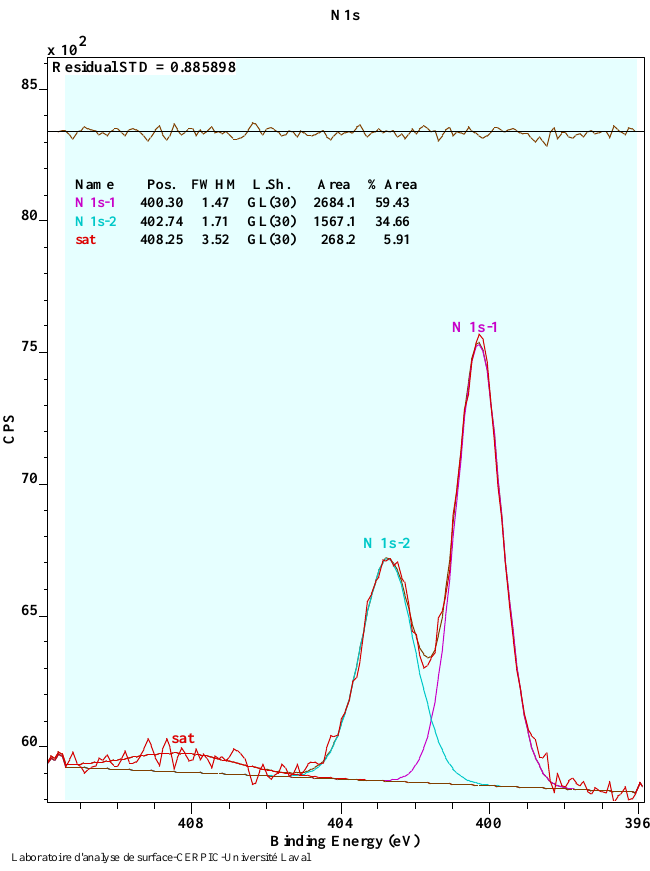
Figure 8. N 1 s high resolution spectra on embedded UVAs into CaCO 3 sample.